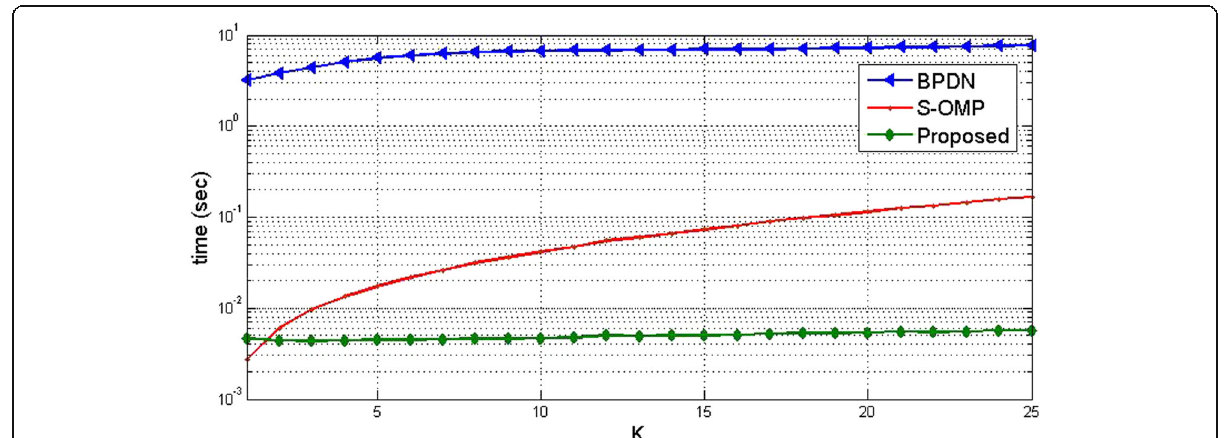
Fig. 4 Running time of the proposed and other algorithms versus the number of targets